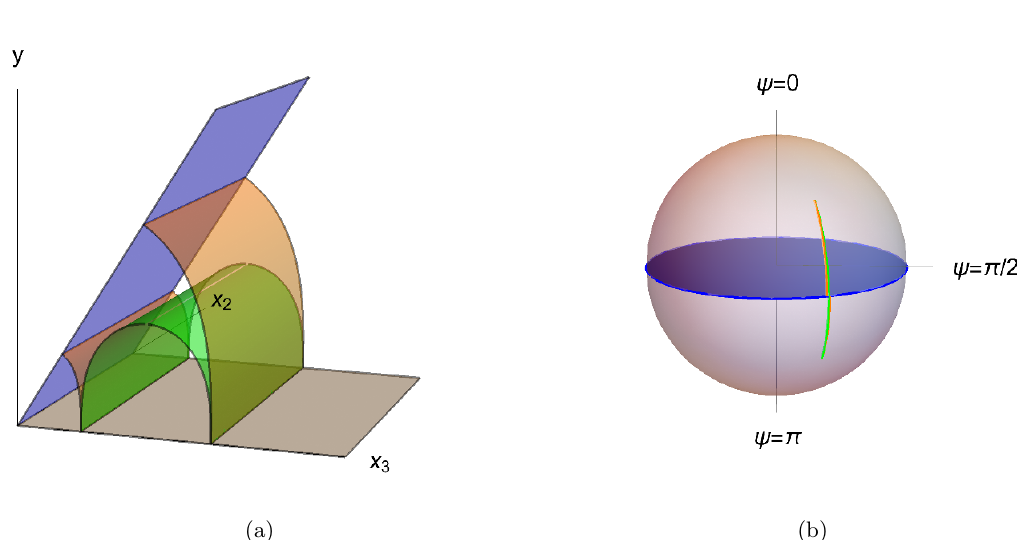
Figure 2 . The D5-brane (3.2) (blue) and the minimal surfaces corresponding to two disconnected worldsheets (orange) and the connected surface (green). On the left, the antiparallel lines (2.2) run at constant distance x 3 = L (cid:6) from the defect located at x 3 = y = 0. The double-scaling limit (1.2) with (cid:20) (cid:29) 1, relevant for matching results in the dual gauge theory, corresponds to the AdS 4 hyperplane of the brane making a tiny angle with the boundary y = 0. On the right, the strings run along a longitude of S 5